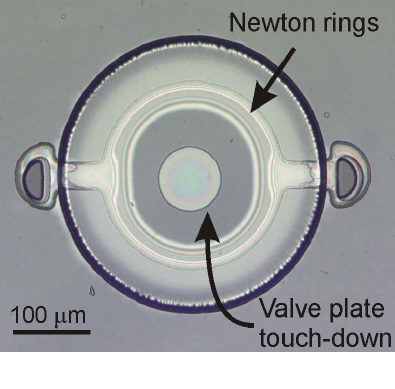
Figure 5. Optical micrograph of 300 µm diameter device filled with DI water. The chamber is free standing while the valve is collapsed and pinned to substrate. The dark central region indicates the seal between the annular-plate and substrate while interference rings indicate proximity to substrate as plate transitions from contact at the center to freestanding at the anchored edges ([10] © IEEE